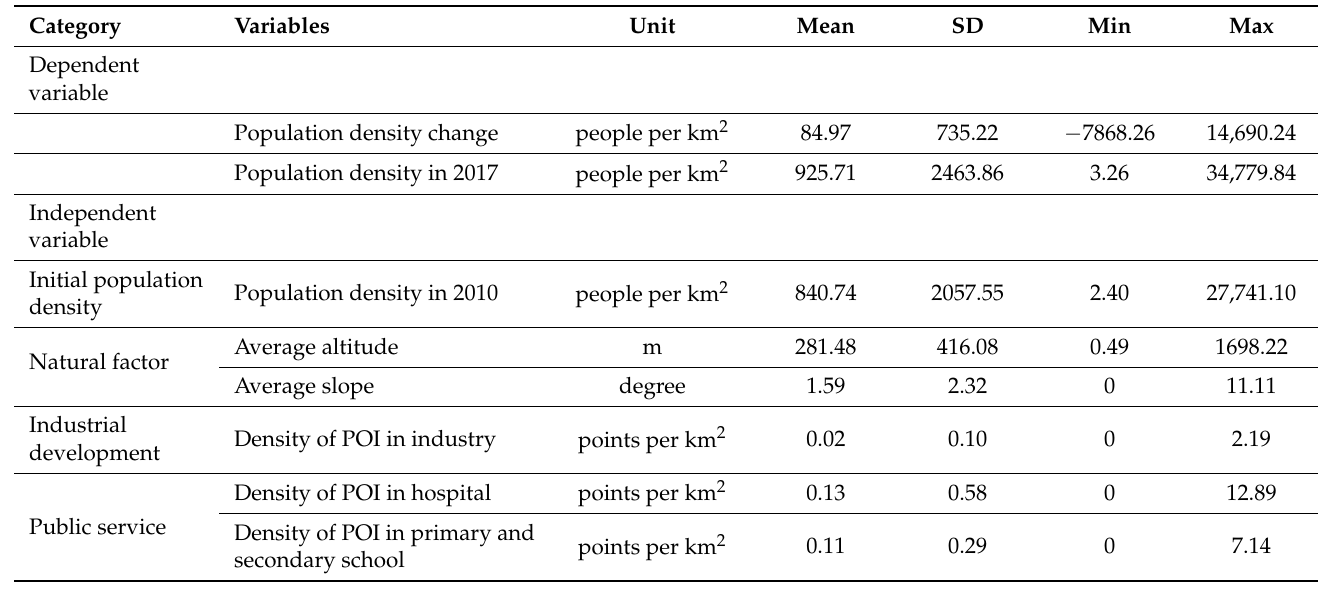
Table 1. Selection and descriptions of township-level